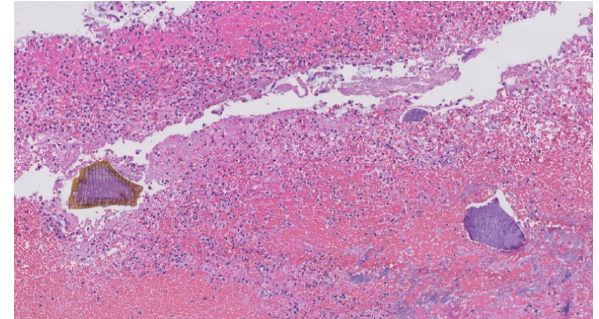
Figure 5: Medium power image of fibrinopurulent exudate, with sevelamer (left) and Kayexalate (right) crystals (Hema- toxylin and eosin, 10×